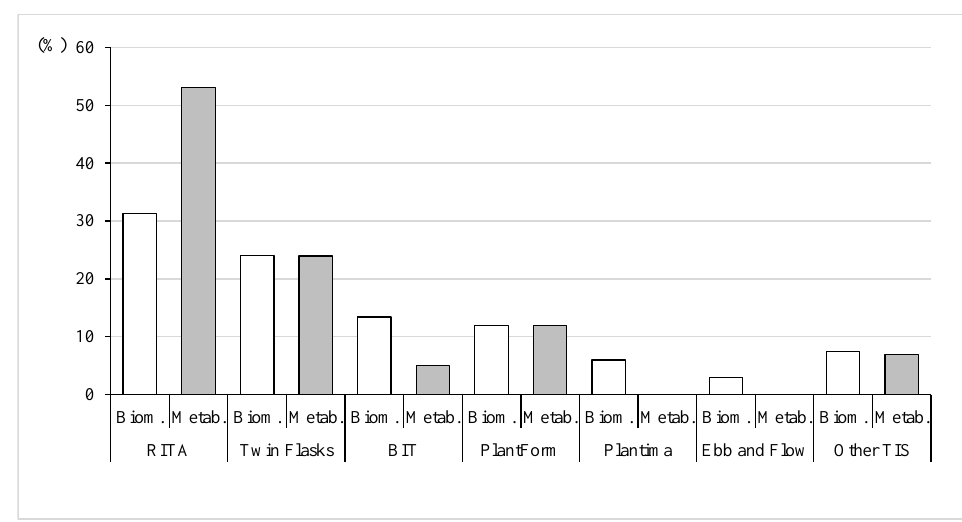
Figure 3. TIS bioreactors application percentage in the reported papers for biomass (61 papers) and bioactive compounds production (36 papers).